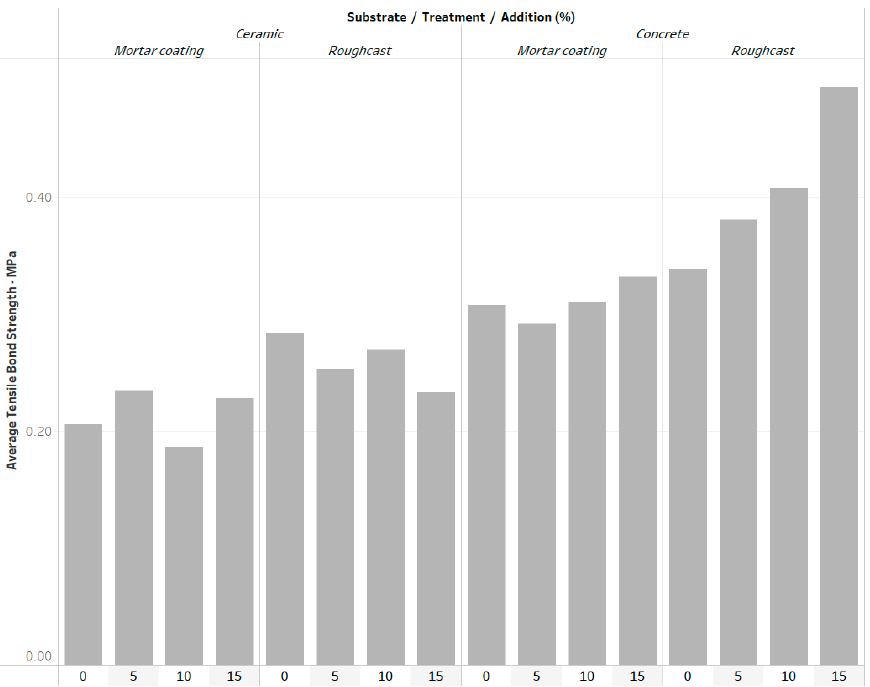
Figure 7. Average tensile bond strength categorized by lime solution addition.